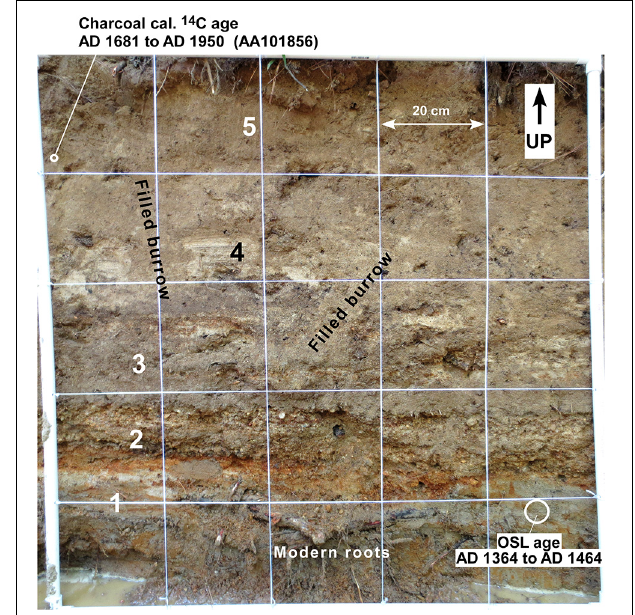
FIGURE 9 | Site G (Wood Creek, 33.60875 ◦ N, 91.83099 ◦ W)—Top is up. Photograph of 1 × 1 m grid on vertical excavation. No liquefaction observed. Unit 1, Wood Creek point-bar, medium -bedded, fine sand; Unit 2, Wood Creek point-bar, medium-bedded gravel; Unit 3, Wood Creek point-bar, inter-fingering medium beds of fine/medium sand and gravel; Unit 4, Wood Creek point-bar, thin-bedded fine sand; Unit 5, Wood Creek overbank, massive loam (aggraded A soil horizon). The detrital charcoal 14 C age from Sample AA101856 post-dates sediment deposition of Units 1 through 4 but does not constrain sediment deposition to before the historic period (our minimum constraint). The quartz OSL age gives the age of Unit 1 deposition and pre-dates deposition of Units 2 through